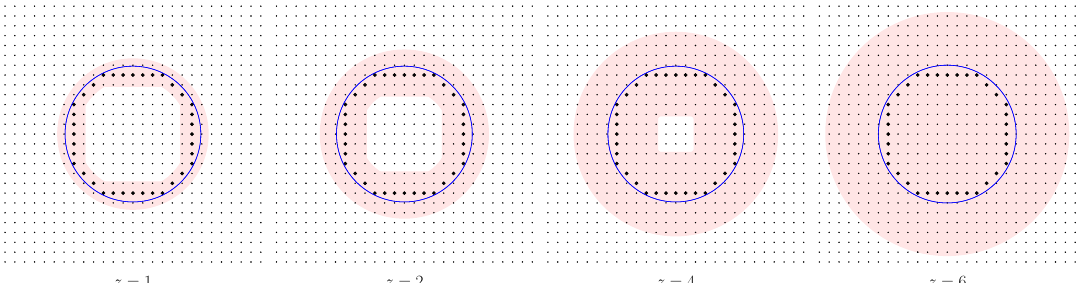
Figure 1 . The nearest points inside a disk entangling region to its boundary are shown in green. Those points which are correlated to the green ones due to the discrete kinetic term of this theory are shown with a red shadow. The left panel belongs to the Lorentzian case z = 1. This shows how we intuitively understand the area law of entanglement for regions which their characteristic length, say ‘ , is much bigger than the lattice spacing (the inverse of the UV cut-o(cid:11)). Moving from the left panel to the right, the dynamical exponent is increasing. One can see that for a disk with a radius 3 : 5 in units of lattice spacing, for z > 6, since all points inside the entangling region are (cid:24) correlated with the green ones, we expect entanglement measures to scale with the volume (instead of the area) of the entangling region. We will show numerically that this is the correct scaling of entanglement entropy for large enough z in the following of this paper. Although this (cid:12)gure belongs to (2 + 1)-dimensions, its horizontal (vertical) slices describe what happens in (1 + 1)-dimensions and it can be generalized to higher dimensions